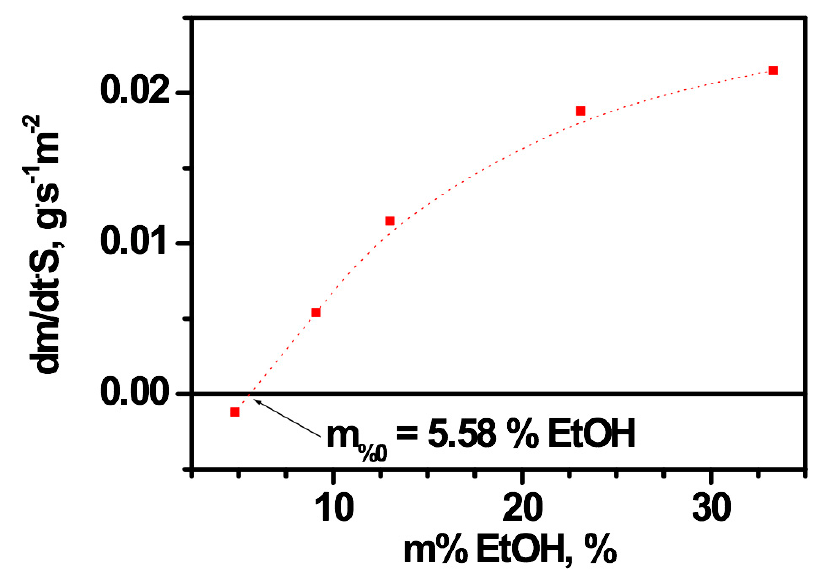
Figure 8. The rate of weight loss dmdt − 1. S − 1 [g s − 1 m − 2 ] for FA as a function of mass % of ethanol in sample. Temperature T = 22 °C, relative humidity H = 25%.